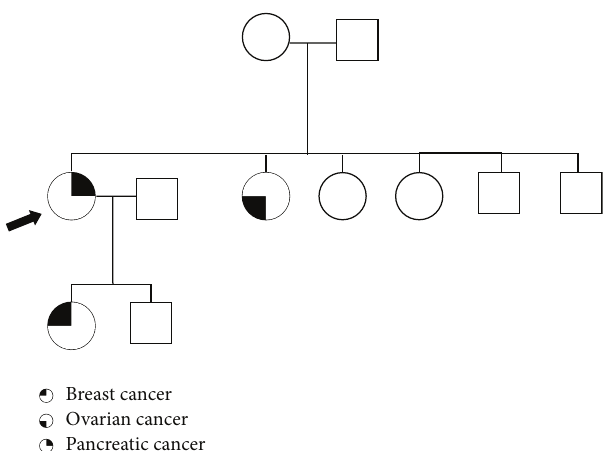
Figure 1: Pedigree of the affected family. Pedigree shows the three family members tested for BRCA2 mutation and known tumor burden; arrow points to the index patient described in this report. Other family members were not tested or no information could be obtained. Notably, the three affected family members suffered from completely different tumor types which are, however, all parts of the HBOC tumor